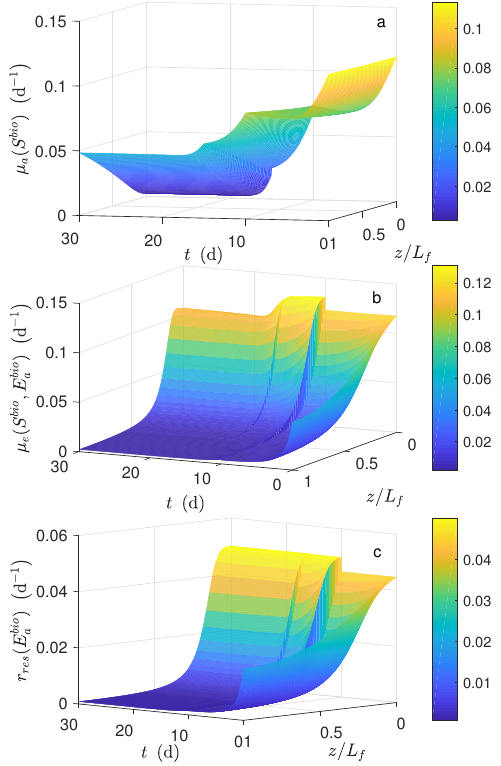
Figure 7. Numerical solution for the MEC model during chronoamperometry operation. Local reaction rate profile ( a ) µ a ( S bio ) , ( b ) µ e ( S bio , E bio a ) and ( c ) r res ( E bio a ) .